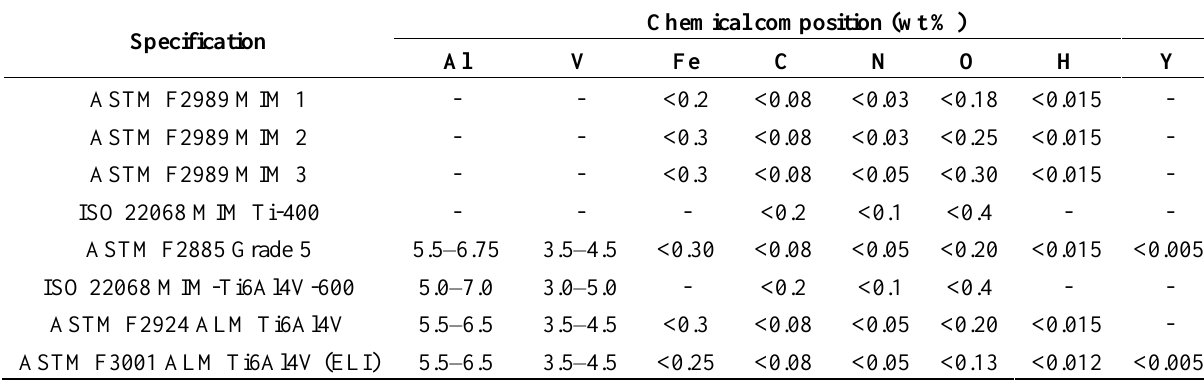
Table 2. Chemical composition requirements for metal injection moulding (MIM) and additive layer manufacturing (ALM) titanium according to American Society for Testing and Materials (ASTM)